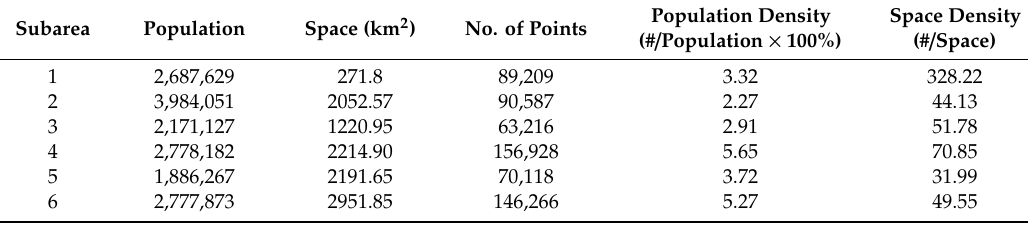
Table 3. Population density and space density based on number of